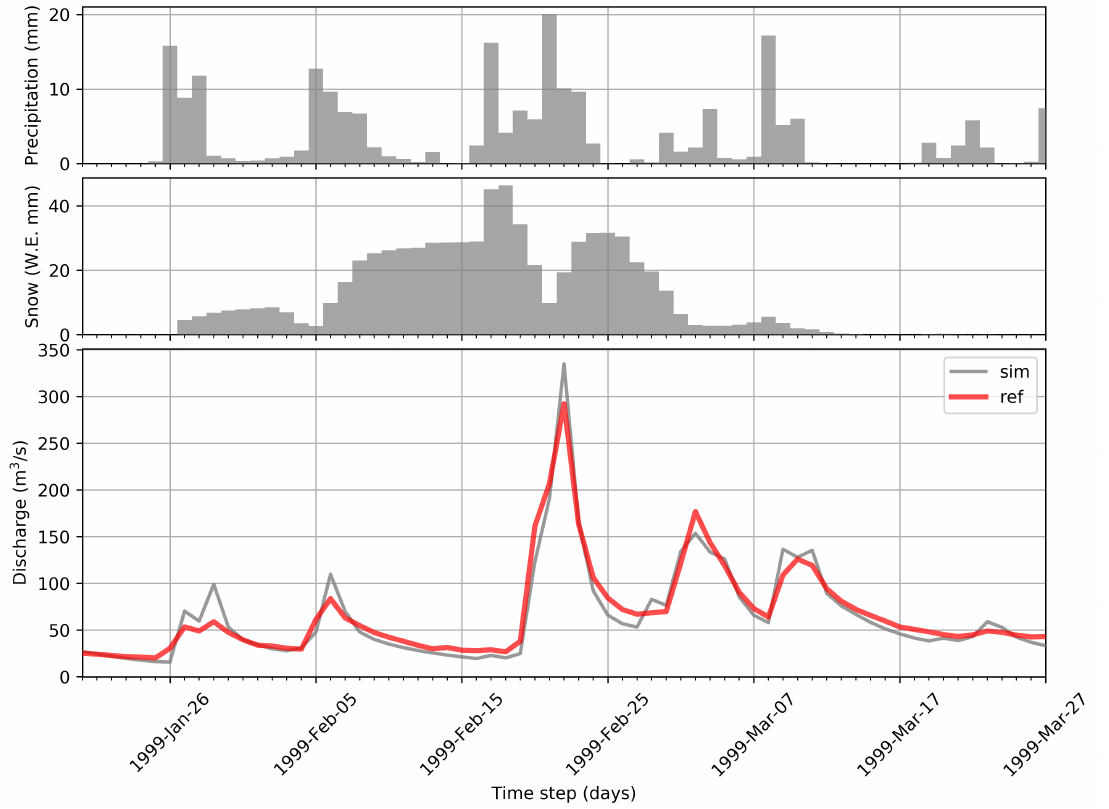
Figure 3. A calibration period large snow melt event using